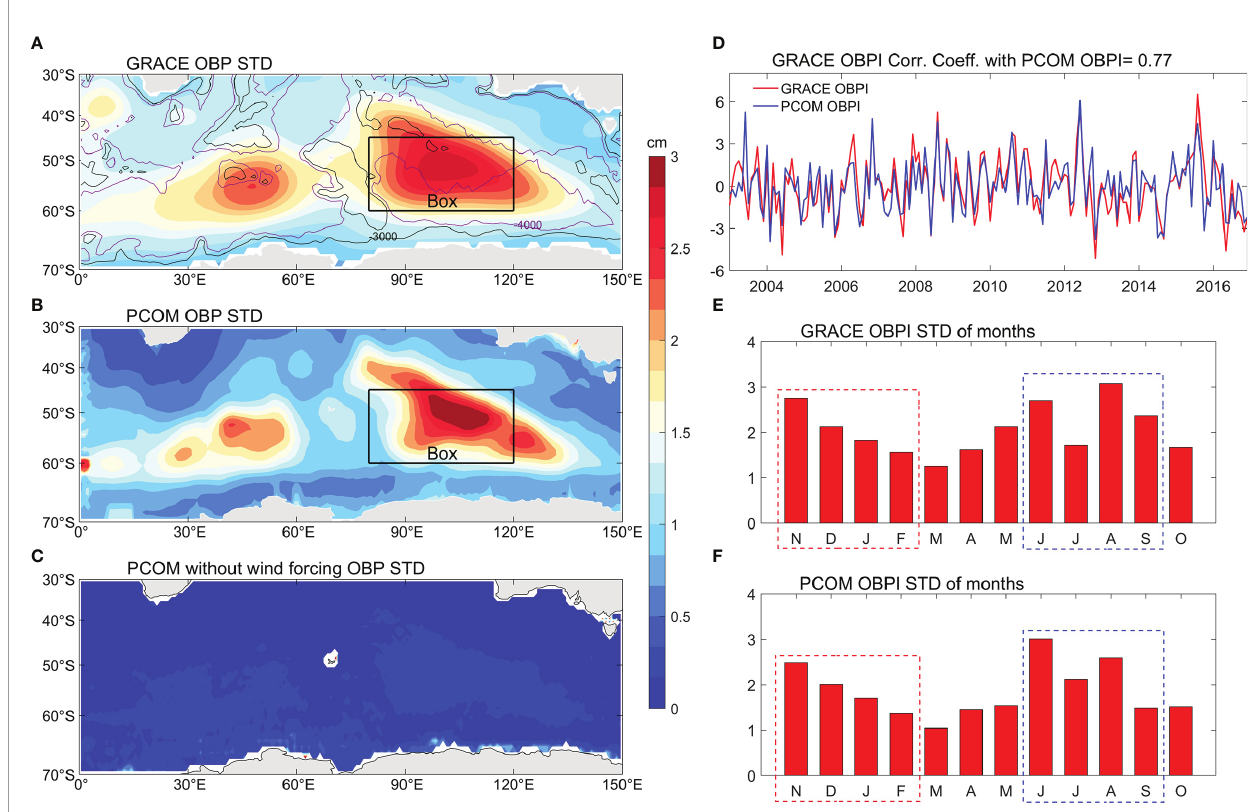
FIGURE 1 | Standard deviation map of (A) GRACE OBP anomalies, (B) PCOM OBP anomalies with control runs and (C) PCOM OBP anomalies without wind forcing in the Southern Indian Ocean from 2003 to 2016. The contours represent isobaths from 3000 (black) to 4000 (purple) meters. (D) The GRACE OBP anomalies and PCOM OBP anomalies averaged in the black box (45°-60°S, 80°-120°E, unit: cm) with annual cycle removed, referred to as GRACE OBPI (red line) and PCOM OBPI (blue line), respectively. The standard deviation variation of (E) GRACE OBPI and (F) PCOM OBPI varies with month (unit: